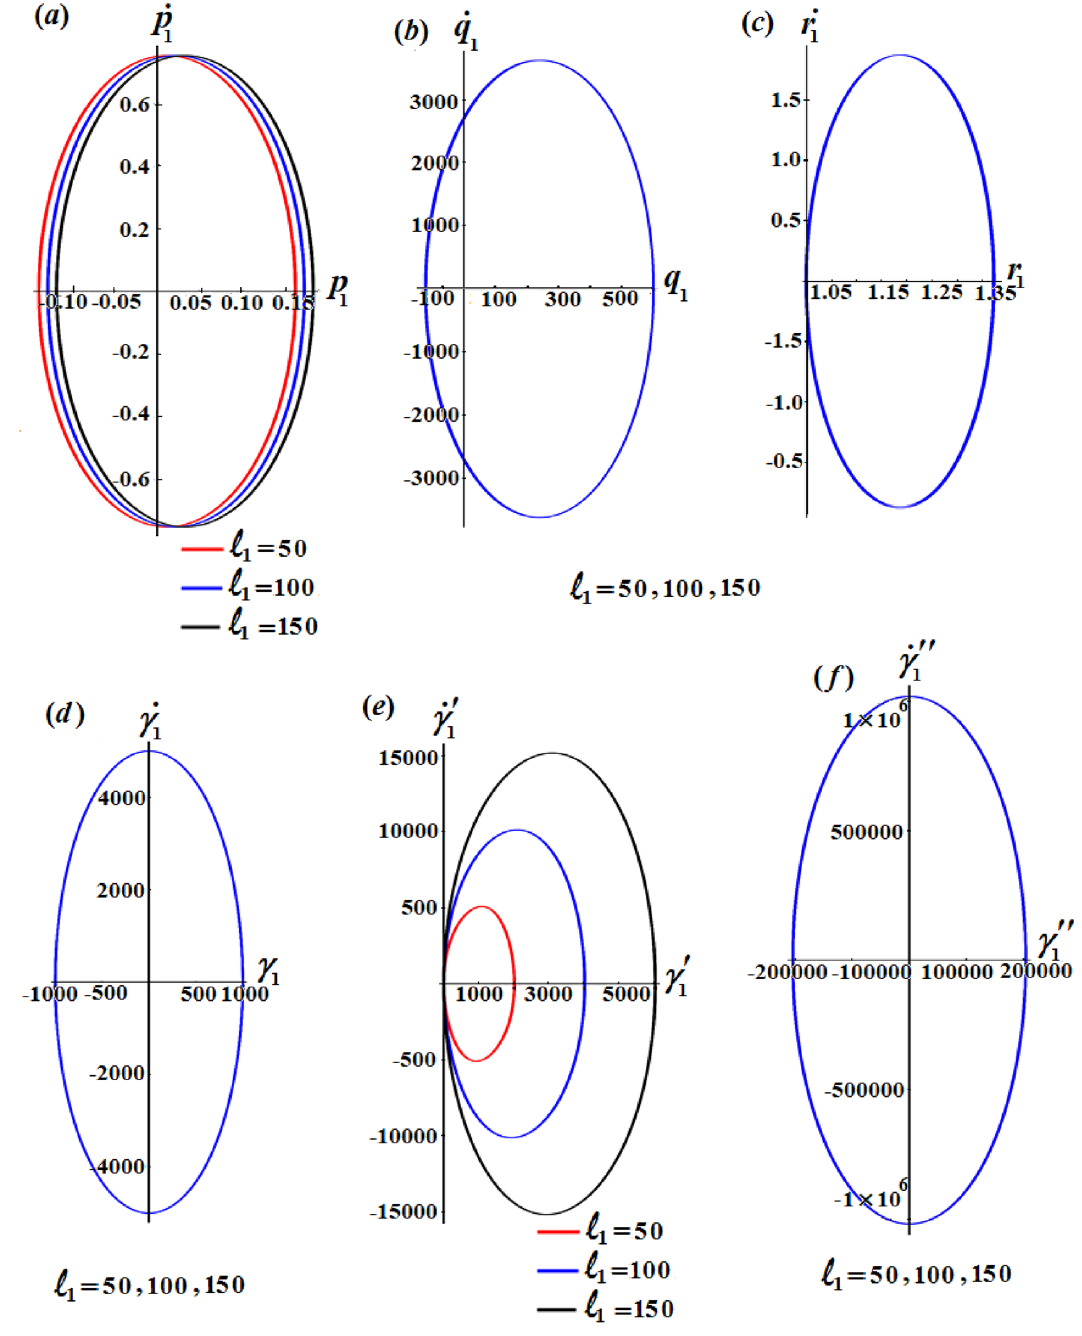
50, 100, 150 ) kg m 2 s − 1 =